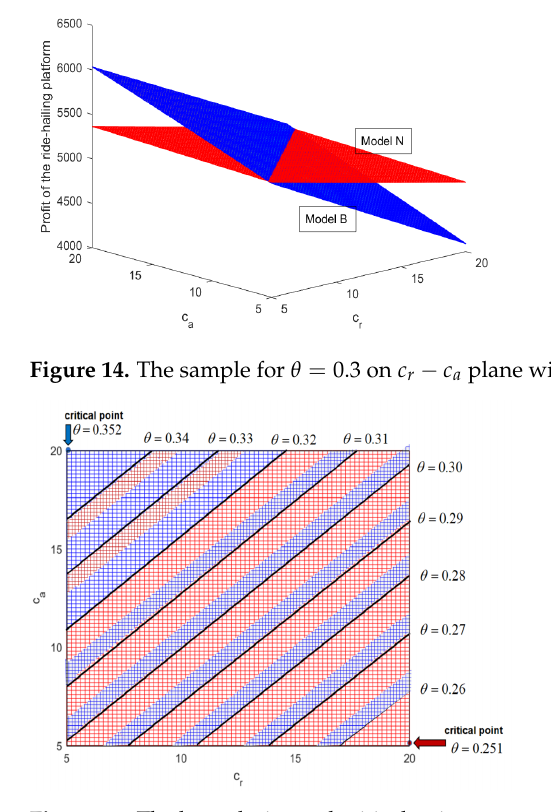
Figure 15. The boundaries and critical points on c r − c a